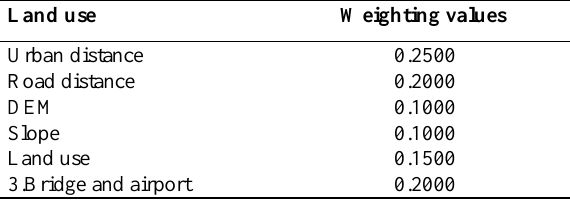
Table 2: MCA weighting values of spatial variables for urban development.